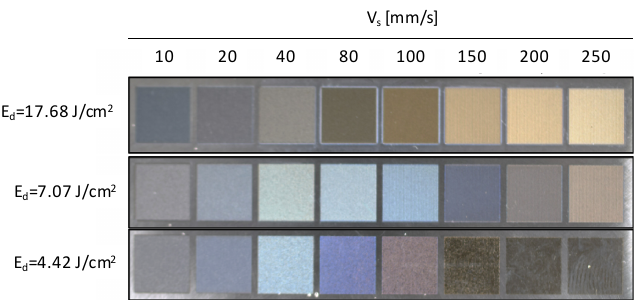
Figure 1. Tonality variations on thermal Ti6Al4V oxidation layers.